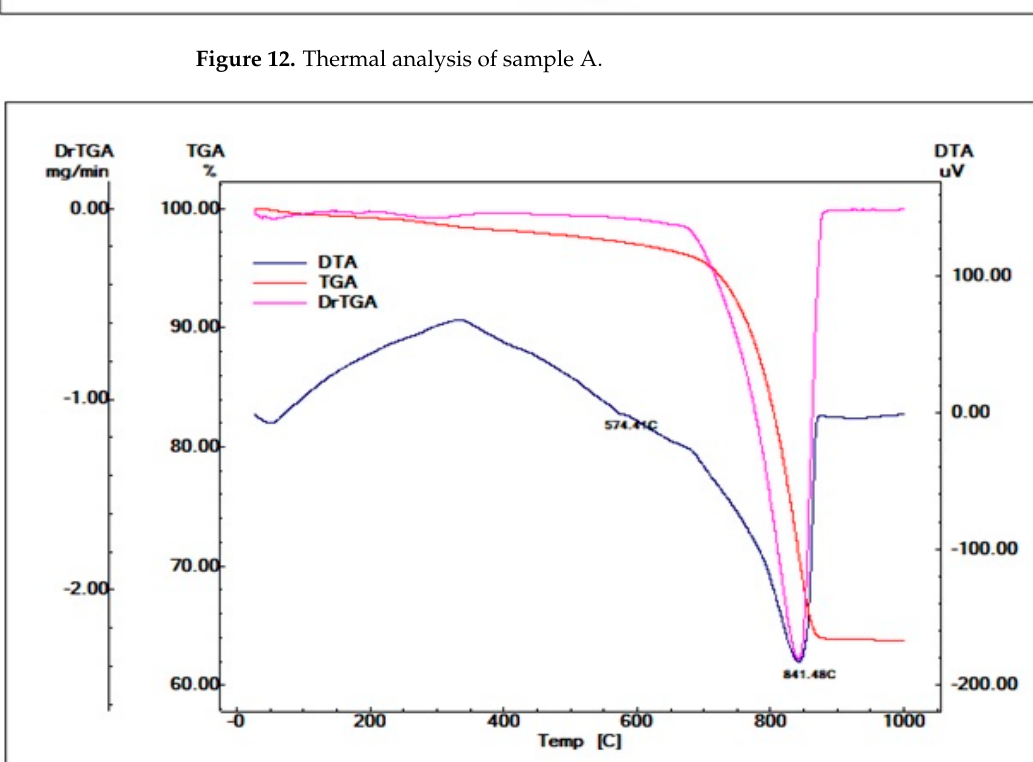
Figure 13. Thermal analysis of sample B.